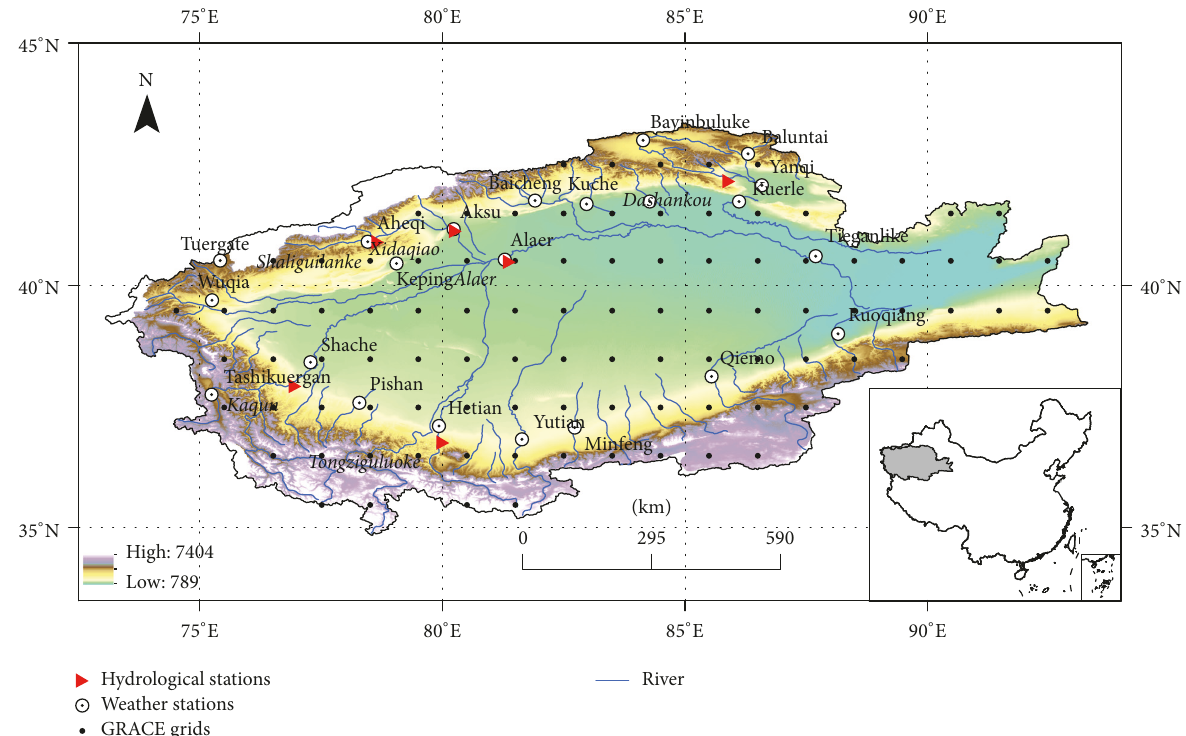
Figure 1: The map of the study